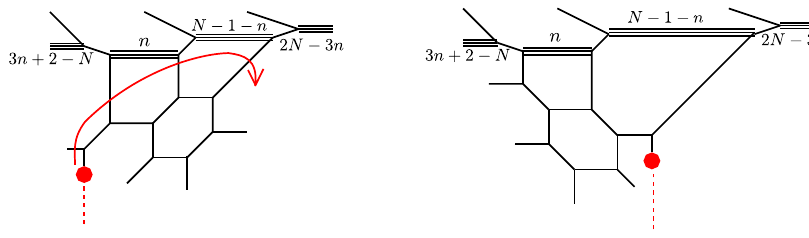
Figure 17 . Derivation of the distribution duality